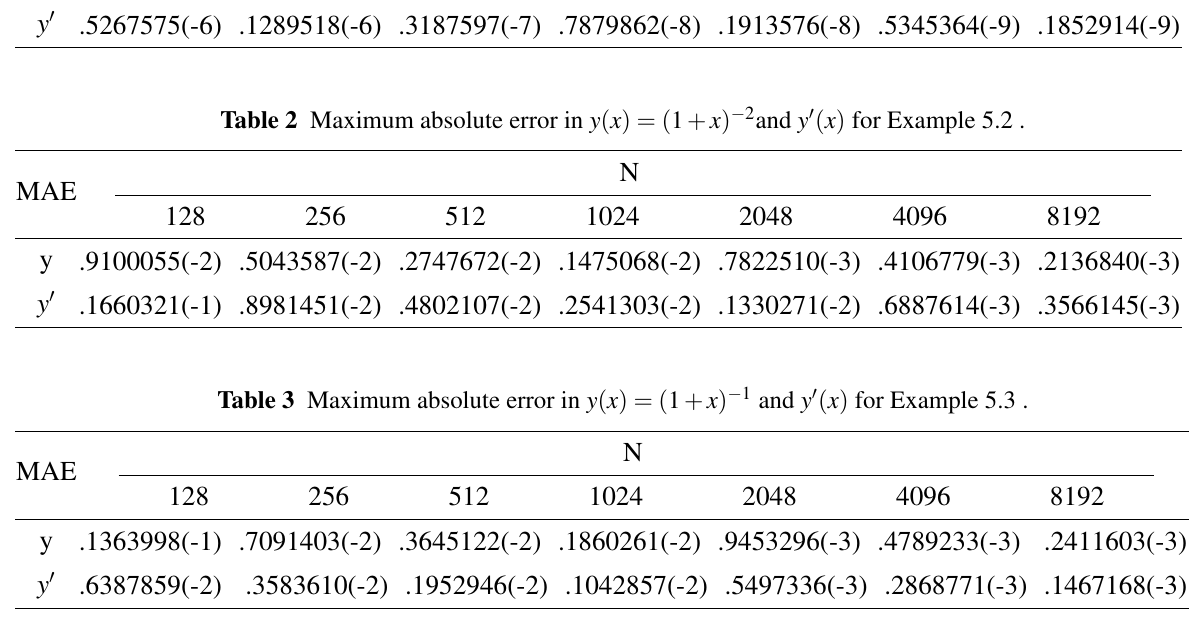
Table 1 Maximum absolute error in y ( x ) = e (